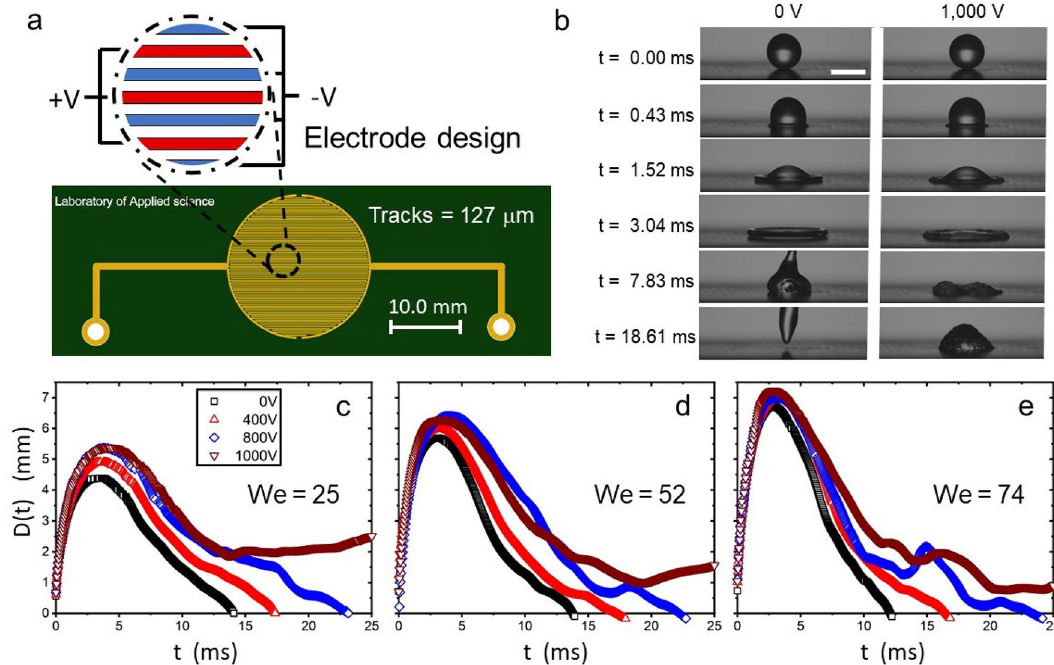
Figure 1. ( a ) Schematics of the PCB substrate showing the electrode configuration and size. ( b ) Image sequence − 1 of a water droplet impacting, at U 0 = 1.01 m s or We = 34, a dielectrowetting flat substrate at 0 V (left) and at a 1000 V (right) electric potentials. The scale bar size is 2.5 mm. Bouncing is observed for the zero potential case but suppressed at 1,000 V. ( d – f ) Spreading diameter, in terms of time, at ( c ) We = 25, ( d ) We = 52 and ( e ) We = 74, for various electric potentials.